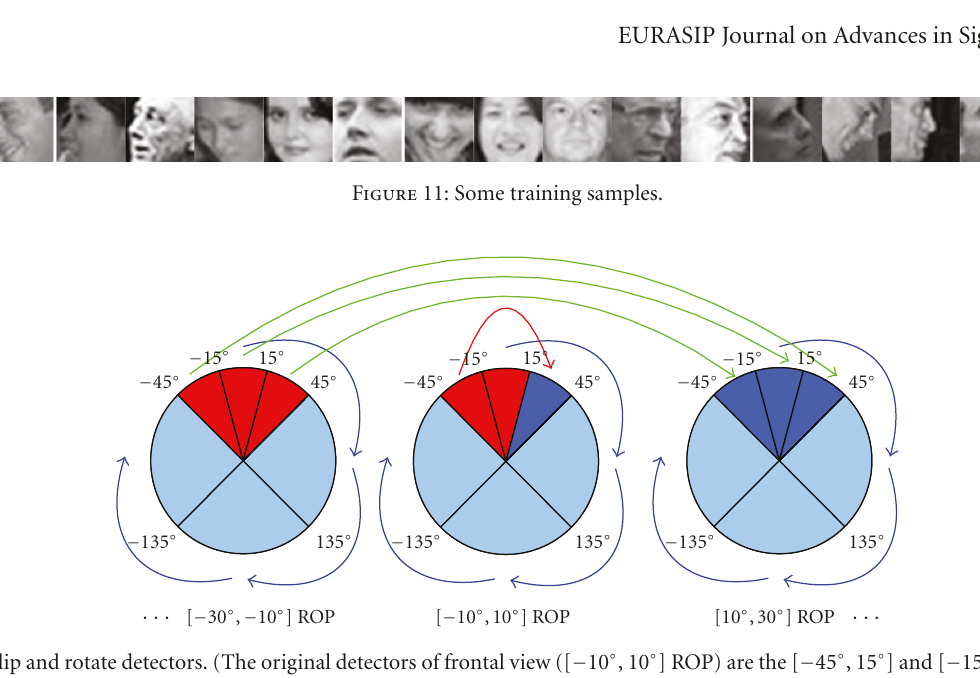
Figure 12: Flip and rotate detectors. (The original detectors of frontal view ([ − 10 ◦ , 10 ◦ ] ROP) are the [ − 45 ◦ , 15 ◦ ] and [ − 15 ◦ , 15 ◦ ] RIP ones. The original detectors of nonfrontal faces are the [ − 45 ◦ , 15 ◦ ], [ − 15 ◦ , 15 ◦ ] and [15 ◦ , 45 ◦ ] RIP ones for each ROP